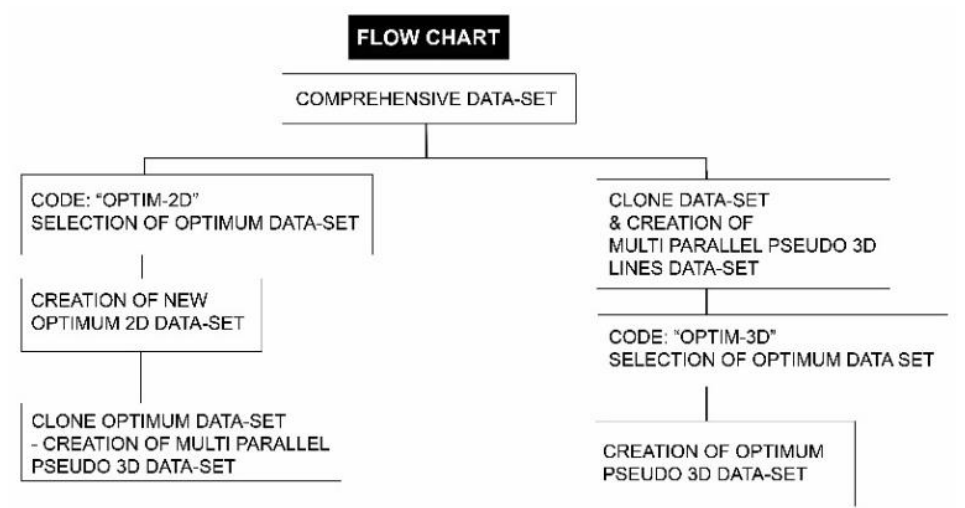
Figure 3. Optimization technique using: “Optim-2D” (2-D algorithm) data set (green-colored) and “Optim-3D” (3-D algorithm) data set (blue-colored). Comprehensive data set (red-colored).